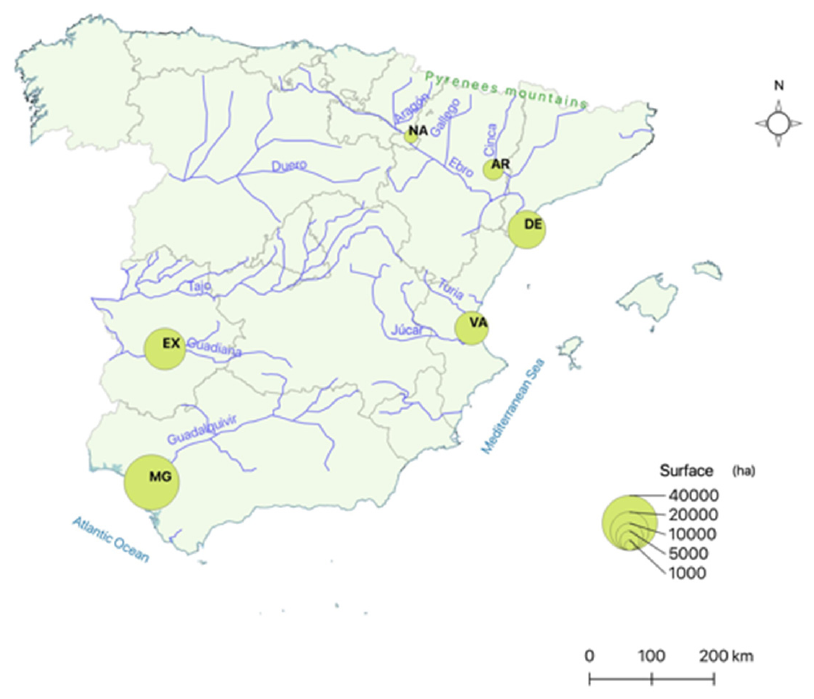
Figure 1. Main rice areas in Spain. AR (Aragon); DE (Delta del Ebro); MG (Marismas del Guadalquivir); NA (Navarre); VA (Valencia); EX (Extremadura).